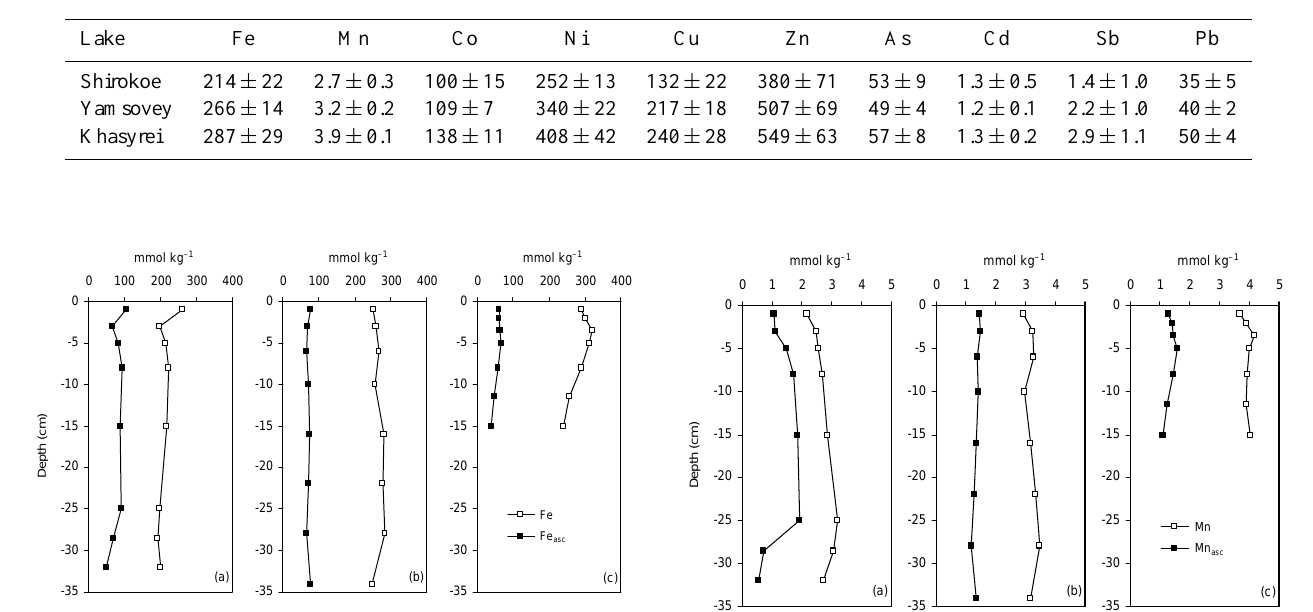
Table 2. Average particulate concentrations (dry weight) and standard deviations of Fe and Mn (mmolkg − 1 ) and trace metals and metalloids (µmolkg − 1 ) in the sediments of Lake Shirokoe, Lake Yamsovey and Lake Khasyrei.